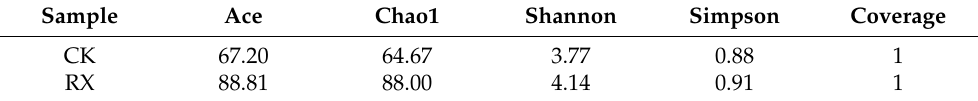
Table 1. Summary of Illumina Miseq high-throughput sequencing of 16S rRNA gene. strains; Table S2: Factors and levels designed of L 9 (3 4 ) orthogonal experiment; Table S3: Analysis of the